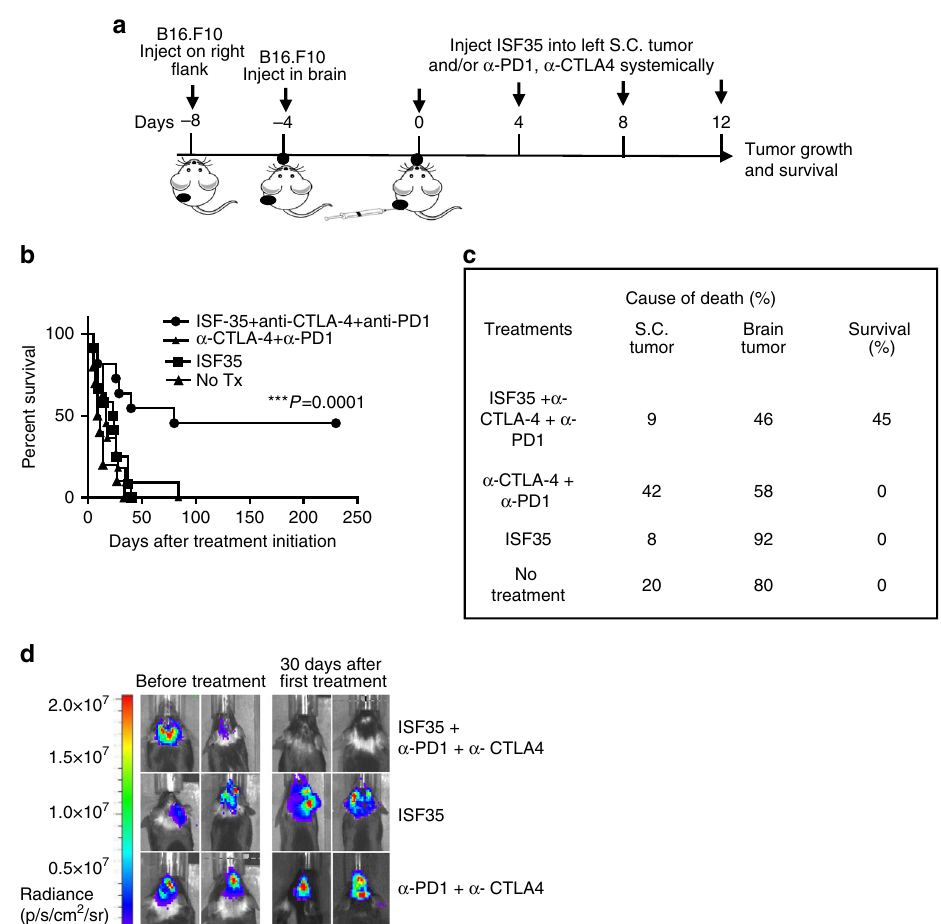
Fig. 7 Synergistic effect of intratumoral ISF35 with anti-CTLA-4 and anti-PD-1 antibody therapy against melanoma in the brain. a Treatment strategy. b Mouse survival. c Cause of death (s.c. or brain tumor). d Representative luminescence images from treated animals. Data are from two pooled independent experiments ( n = 7 in each experiment). Survival analysis was performed with the log-rank test. *** P <